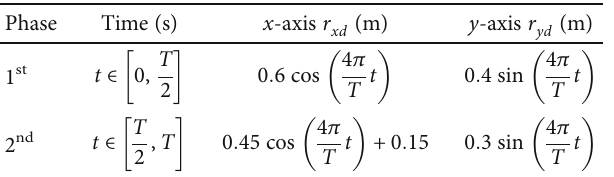
Table 1: Desired trajectory.